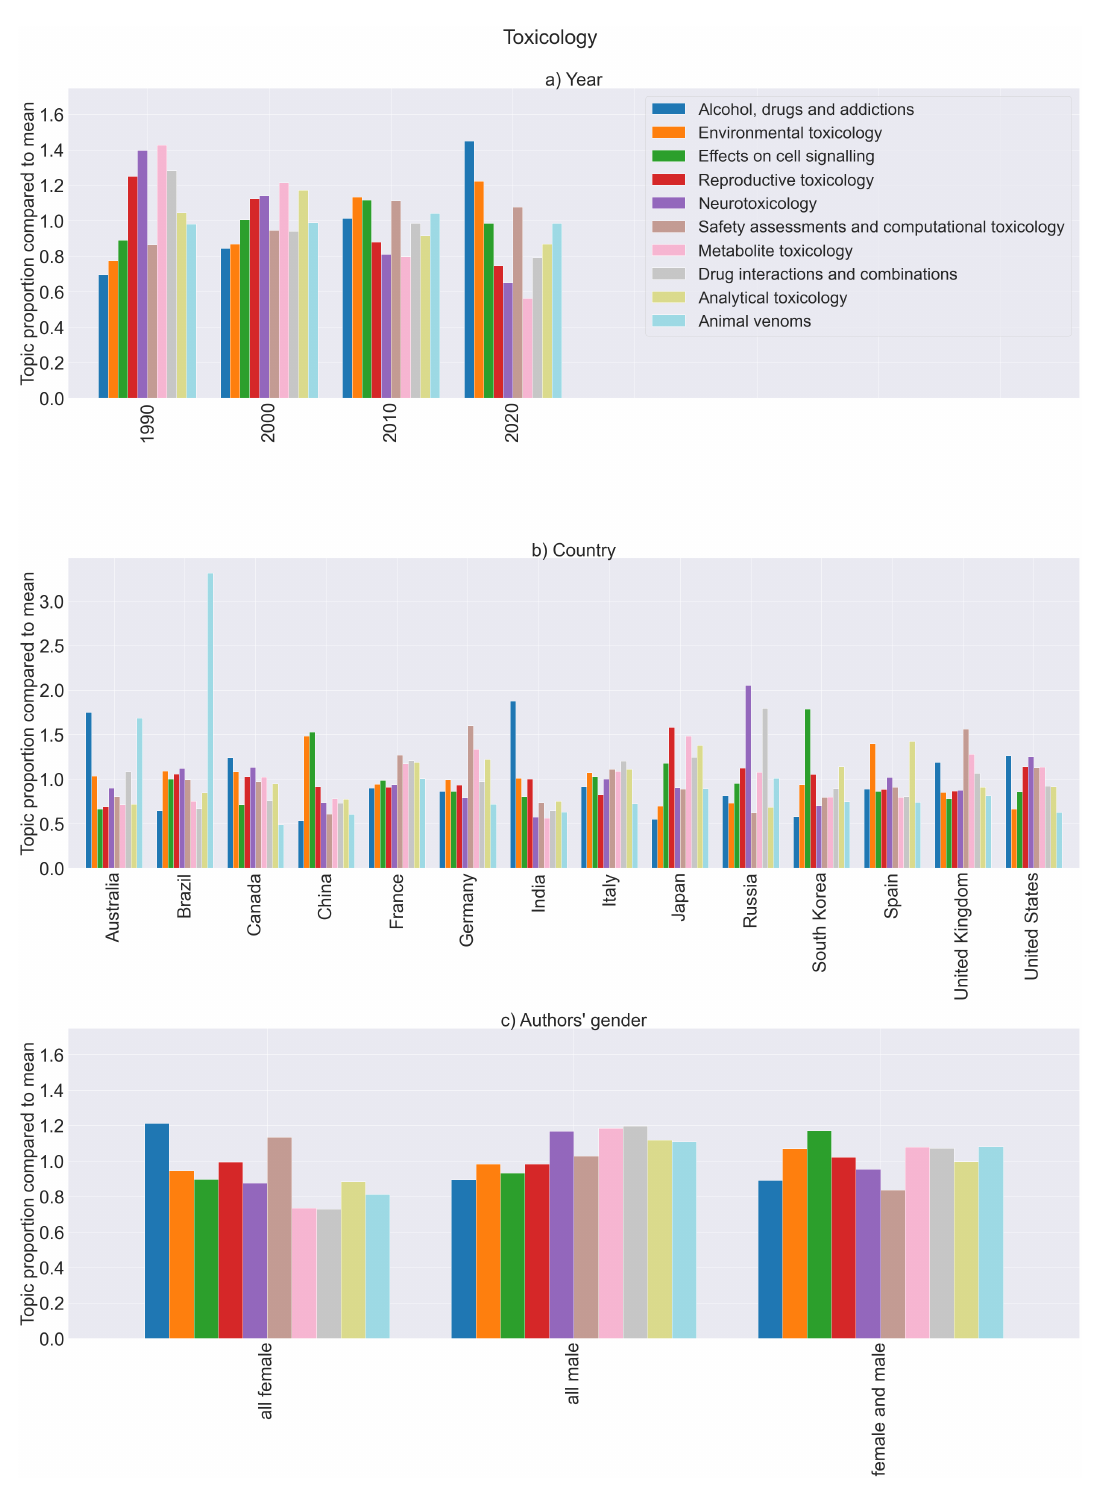
Figure 9. Topic proportion compared to mean, c κ ( ˆ D α ) , for 10 topics of the sub-area toxicology grouped by ( a ) publication year, ( b ) country, and ( c ) authors’ gender. The legend for the topics and their colour codes at the top right corner applies to all three